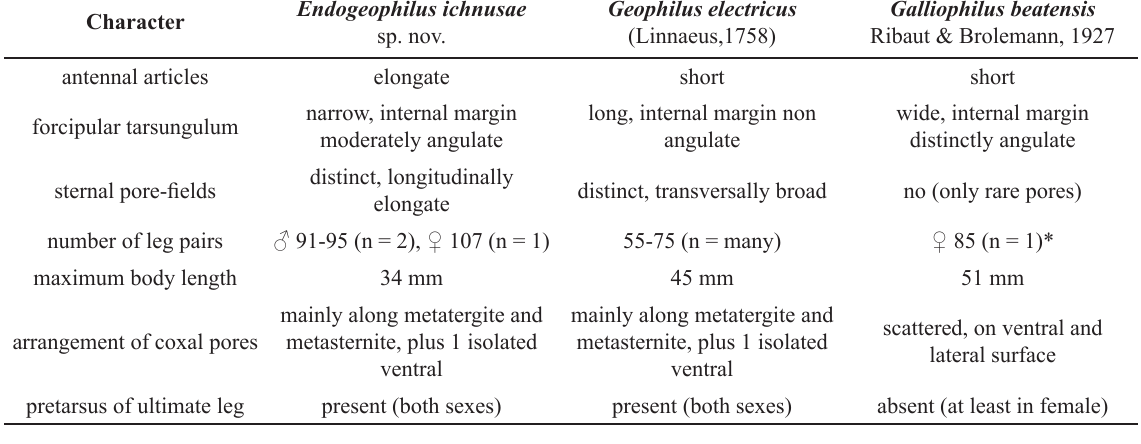
Table 2. Differences between Endogeophilus ichnusae gen. et sp. nov. and the most similar known species of Geophilidae. Information for Galliophilus beatensis Ribaut & Brolemann, 1927 is from Brolemann (1927, 1930). * = García Ruiz & Serra (2000) reported the following values for two specimens from the